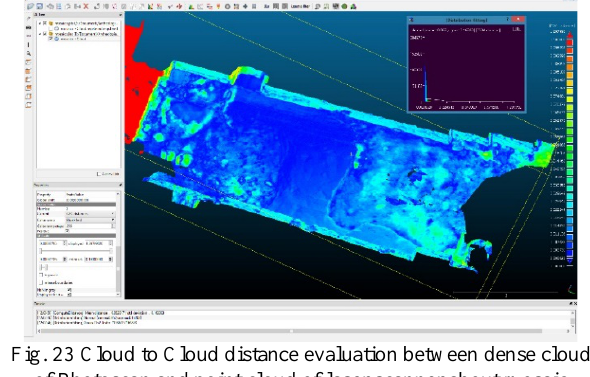
Fig. 23 Cloud to Cloud distance evaluation between dense cloud of Photoscan and point cloud of laser scanner about mosaic floor at Insula Volusiana: “fixed scale” function is enabled.